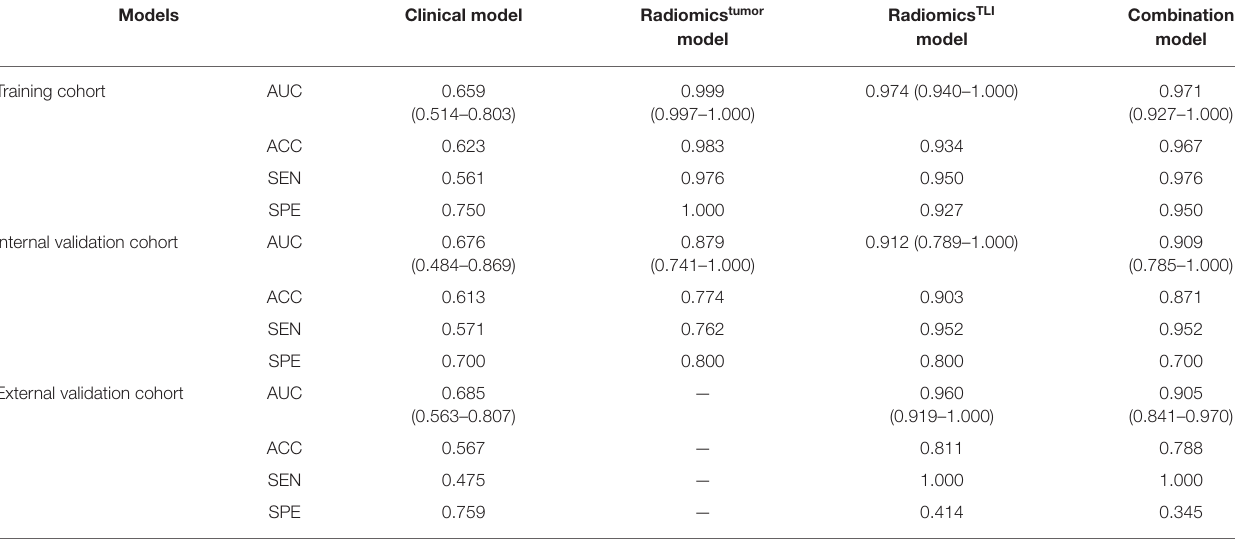
TABLE 3 | Performance of the clinical, radiomics, and combined models in distinguishing HGPs of CRLMs.